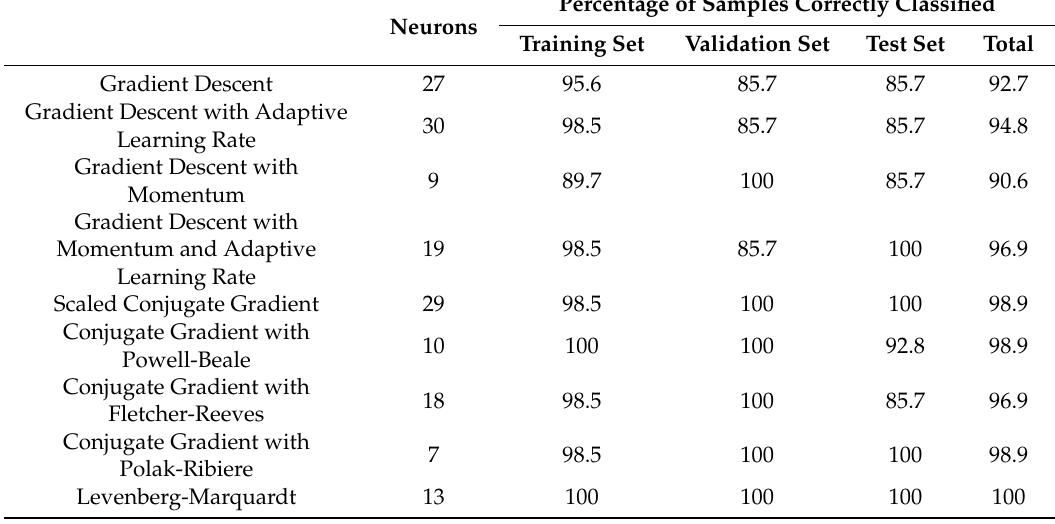
Table 3. Architecture and discrimination results of the best artificial neural network (ANN) find for each of the assayed learning